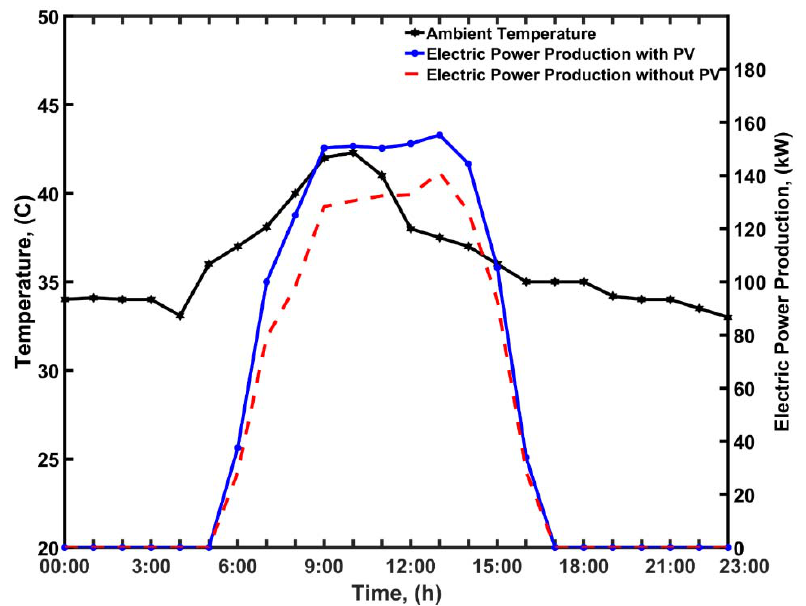
Figure 5. The influence of ambient temperature on the performance of the PV-SCPP and SCPP designs.